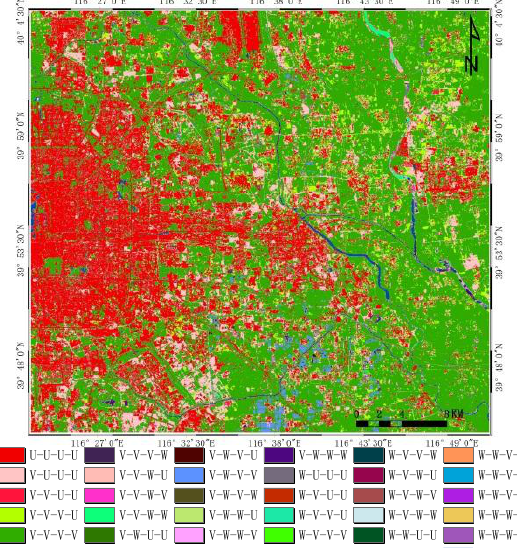
Figure 1 change trajectory from 2008 to